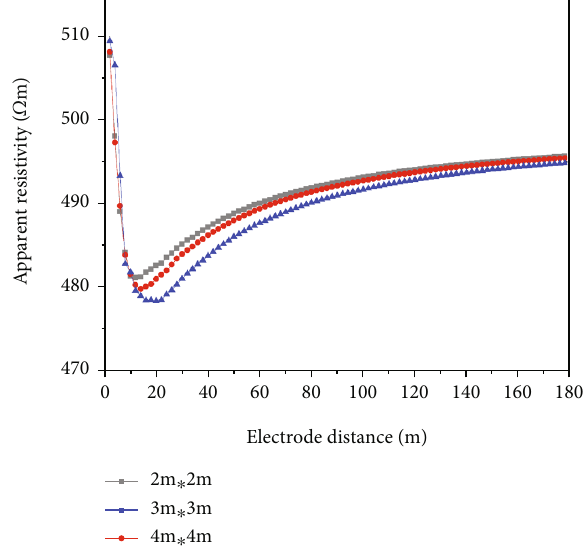
Figure 6: Apparent resistivity pro fi les under di ff erent tunnel sizes at d = 10m